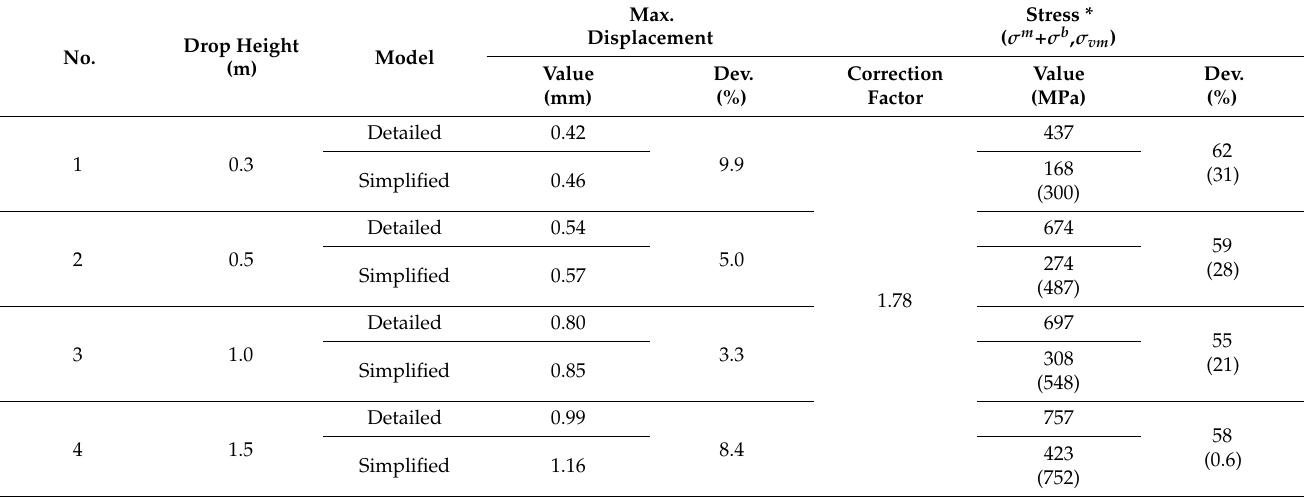
Table 7. Results of the dynamic analyses for the fully bonded condition.